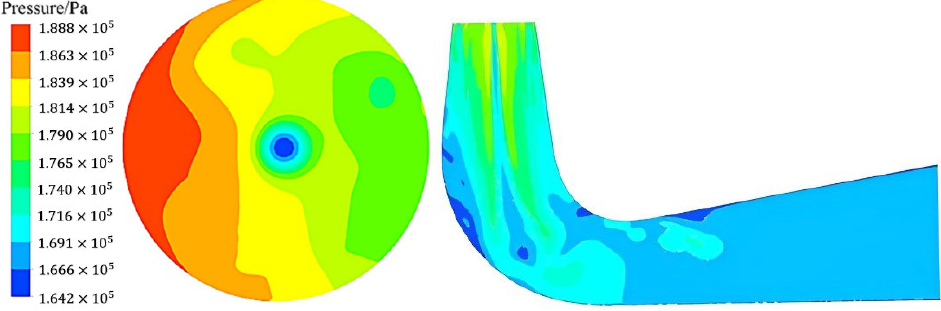
Figure 9. Pressure and velocity distribution of sections of the draft tube [40].